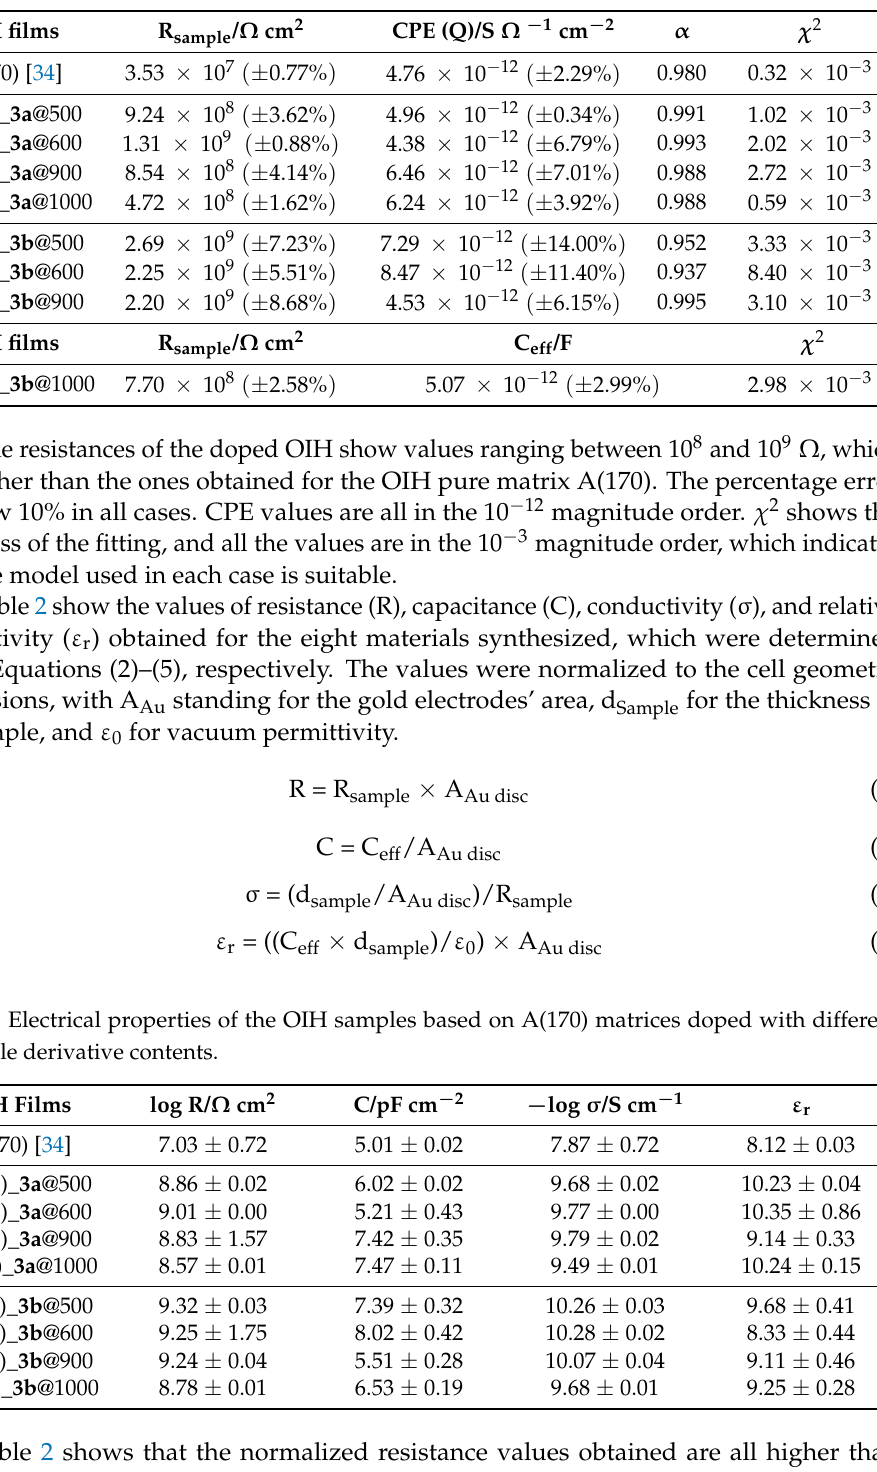
Table 1. Elements of the proposed EEC obtained from the EIS data fitting of the doped A(170) matrices.